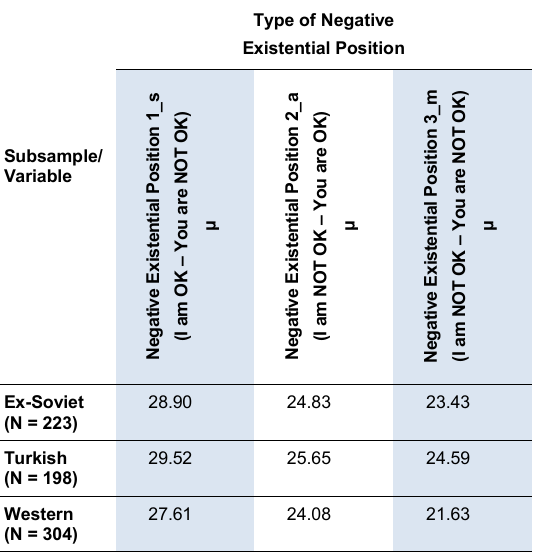
Table 3: Mean Scores on the Negative Existential